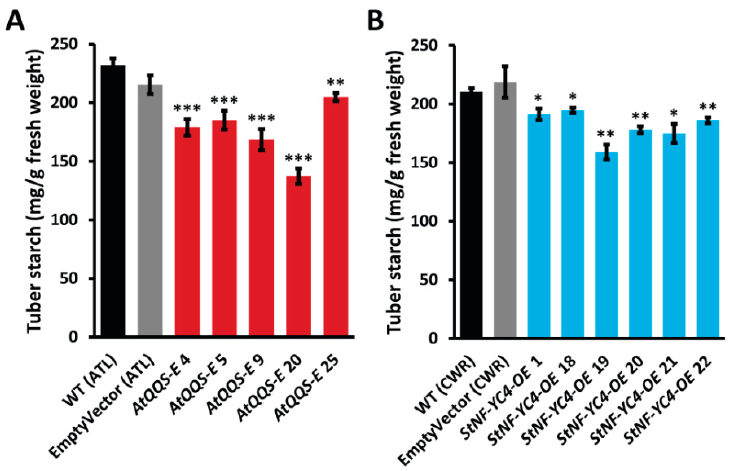
Figure 3. Starch accumulation was decreased in potato tubers expressing AtQQS and overexpressing StNF-YC4-OE . The starch content of AtQQS-E ( A ) and StNF-YC4-OE ( B ) potato tubers were quantified by Megazyme’s GOPOD starch quantification assay. All data in the bar chart show mean ± SE, n ≥ 4. All tubers in ( A ) are of ATL variety, and tubers in ( B ) are of CWR variety. Student’s t -test was used to compare starch contents of AtQQS-E and StNF-YC4-OE to corresponding WT, *** p < 0.001; ** p < 0.01; * p < 0.05.